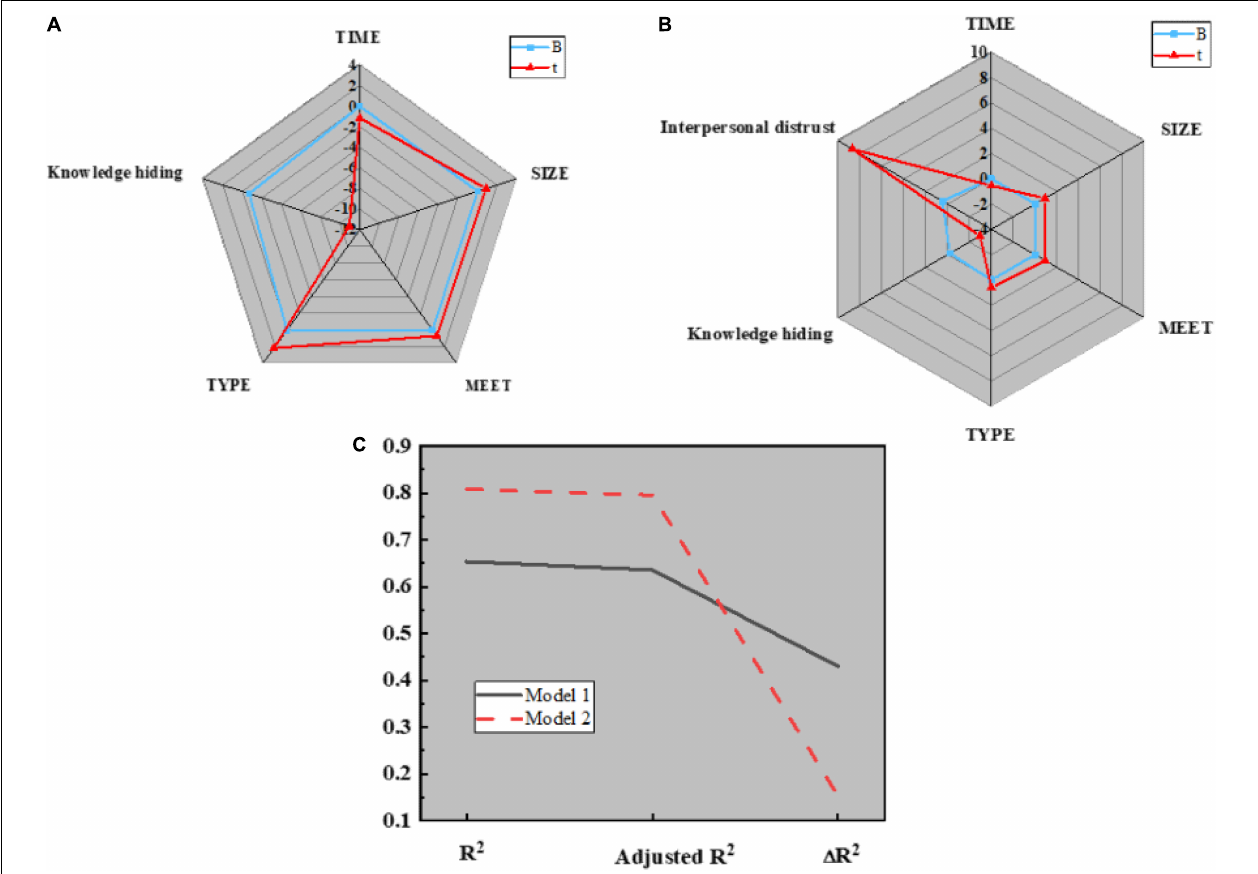
FIGURE 13 | Regression analysis of the mediating effect of interpersonal mistrust on knowledge hiding and temporary team performance. (A) Regression model 1; (B) Regression model 2; (C) Parameter